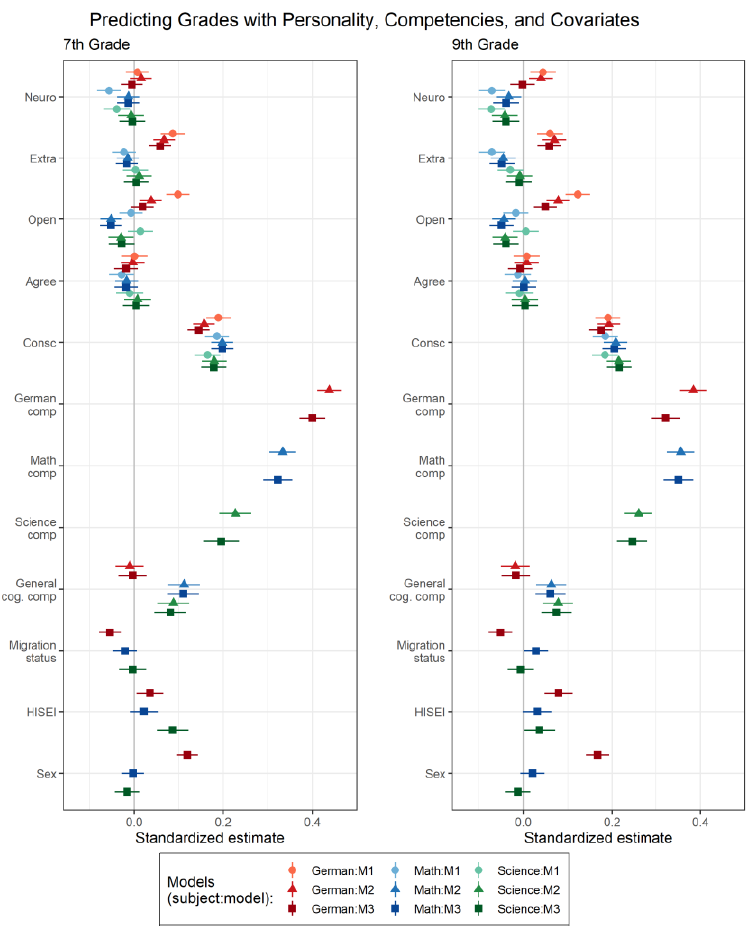
Figure 2. Standardized estimates for the cross-sectional models. Results are shown for the increas- ingly comprehensive models M1 – M3 separately for the subjects and grade levels. Neuro = neuroti- cism; Extra = extraversion; Open = openness; Agree = agreeableness; Consc = conscientiousness; comp = competence; cog = cognitive; HISEI = Highest International Socio-Economic Index of Occu- pational Status.